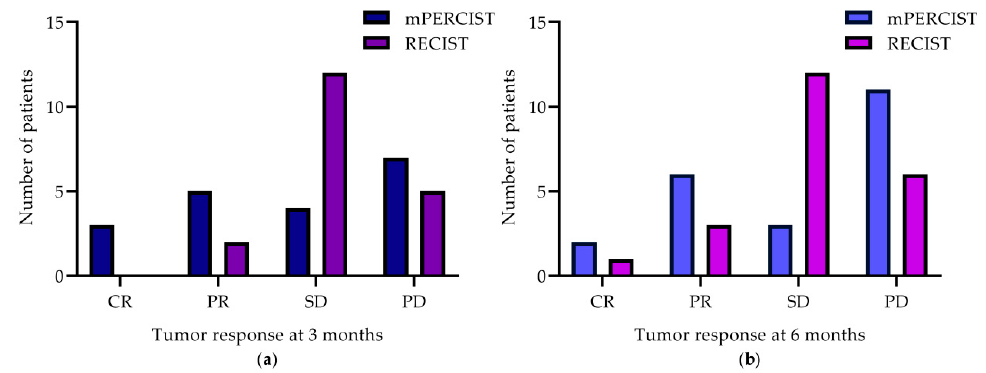
Figure 1. Tumor response evaluation by mPERCIST and RECIST criteria at 3 month ( a ) and 6 month ( b ) follow-up imaging. mPERCIST, modified Positron Emission Tomography Response Criteria In Solid Tumors; RECIST, Response Evaluation Criteria in Solid Tumors; CR, complete response; PR, partial response; SD, stable disease; PD, progressive disease.